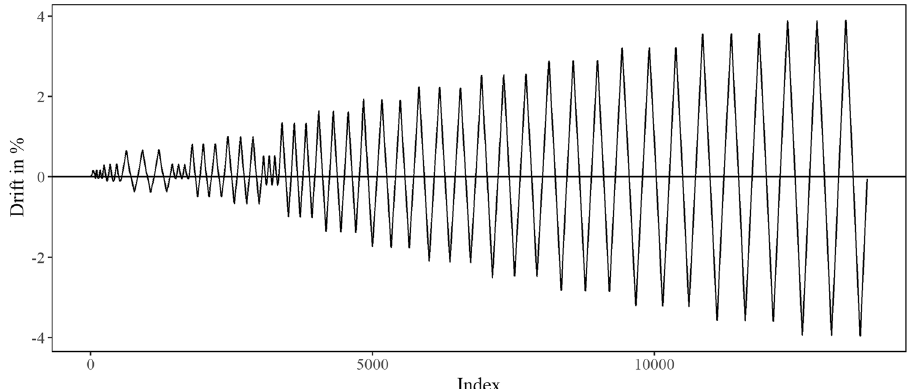
Figure 4. Loading protocol.